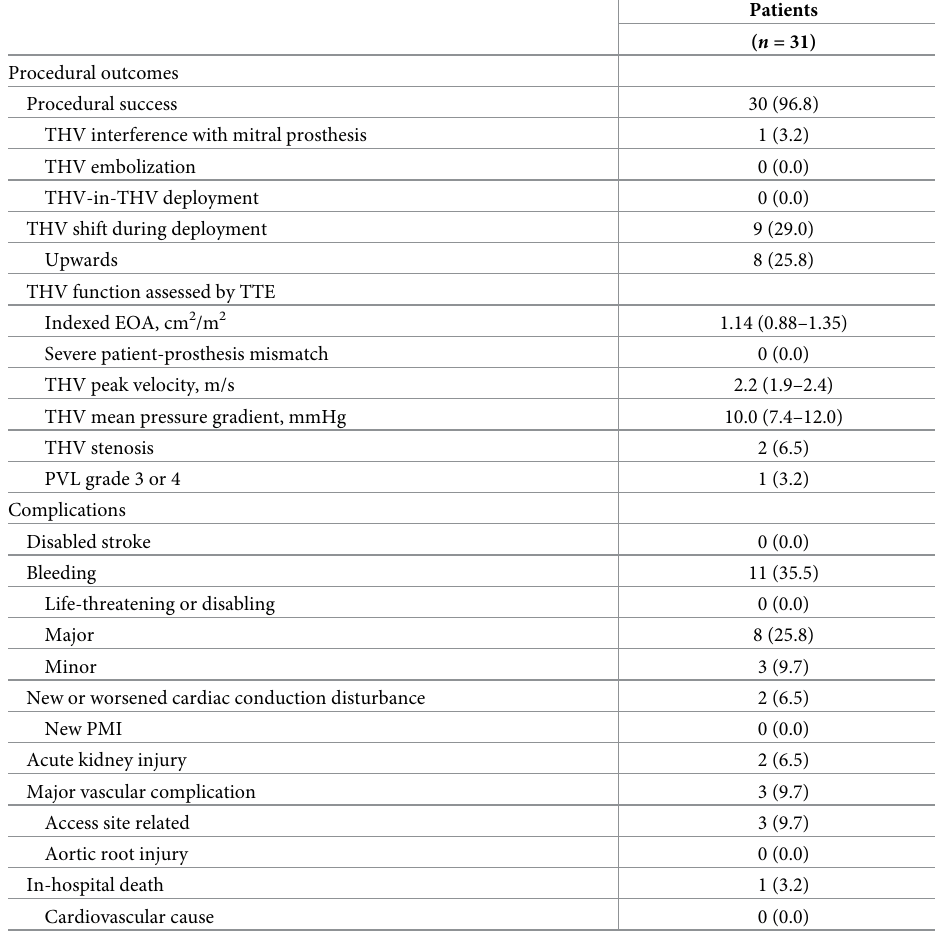
Table 2. Procedural outcomes and in-hospital